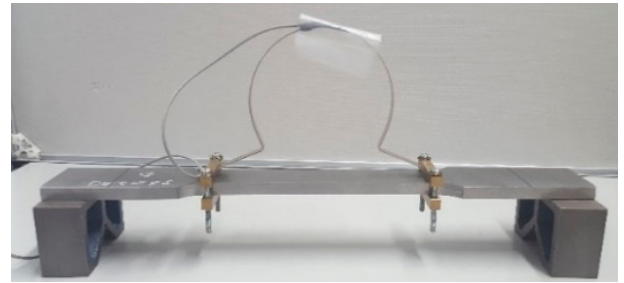
Figure 6. Photo of Ω extensometer. Figure 6. Photo of Ω